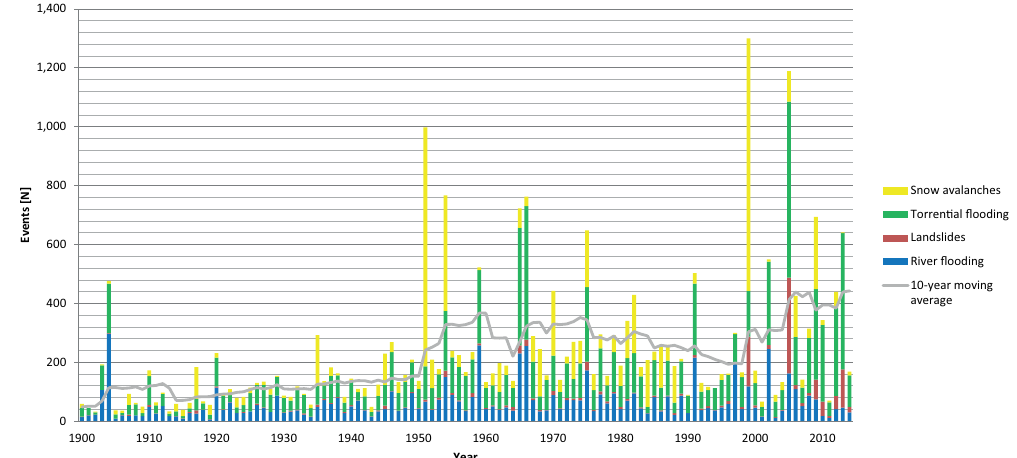
Figure 1. Annual number of documented natural hazards causing losses in Austria. Data source: Austrian Federal Ministry of Agriculture, Forestry, Environment and Water Management,